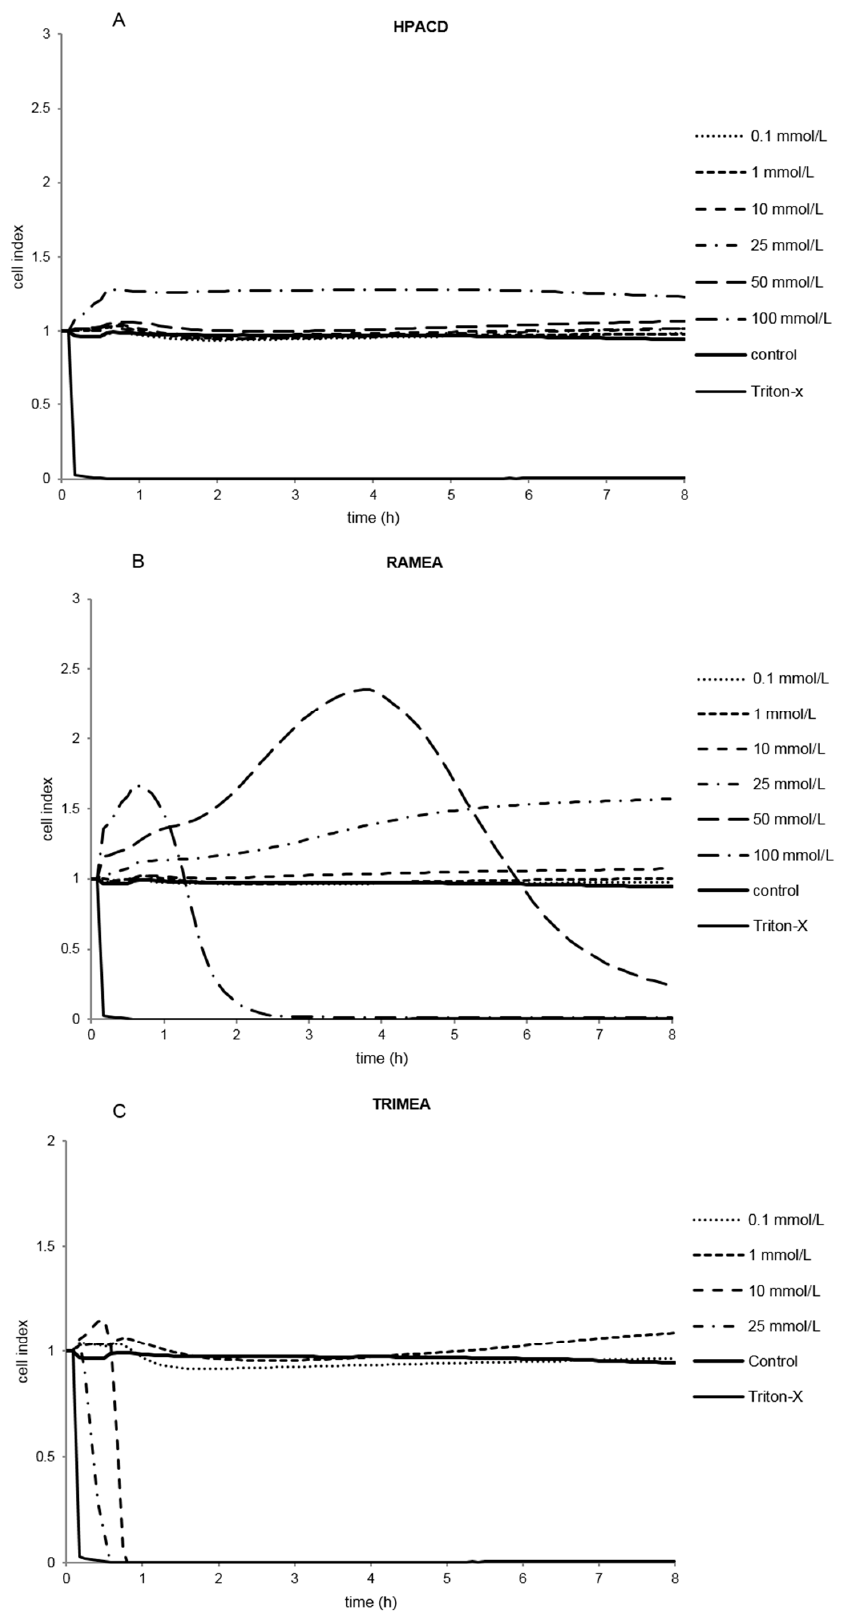
Figure 3. Cont. Figure 3.